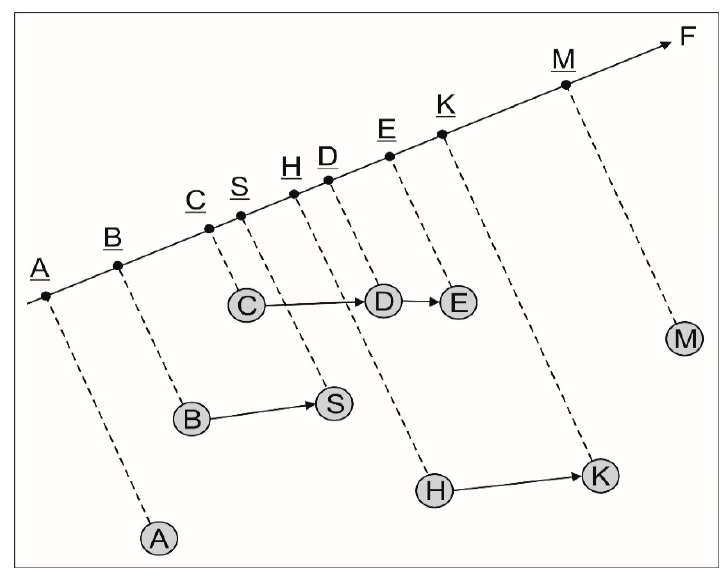
Figure 2. Partial order relation presented as a graph: B precedes ( → ) S; C → D; D → E; H → K. Location of A and M, as well as B and S regarding C, D and E, as well as H and K on axis F is not introduced initially [13]. Axis F describes the location of rock assemblages towards to each other with time.